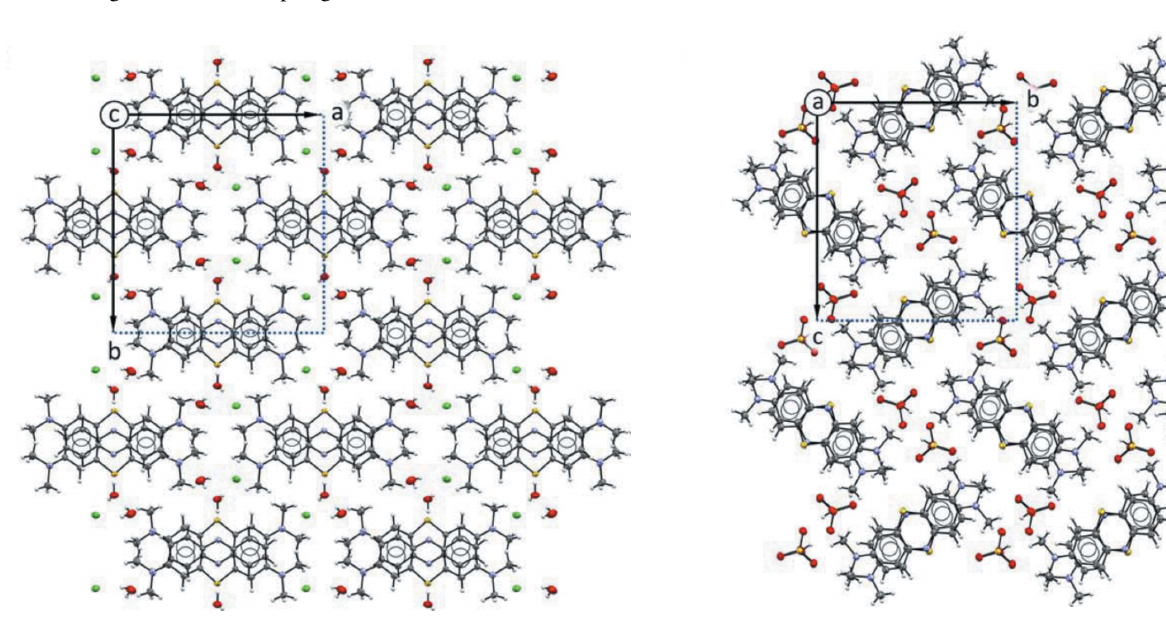
Figure 3 The crystal packing of compound ( I ) viewed along the c axis, with the unit cell highlighted in the upper left-hand corner. Displacement ellipsoids are drawn at the 50% probability level.